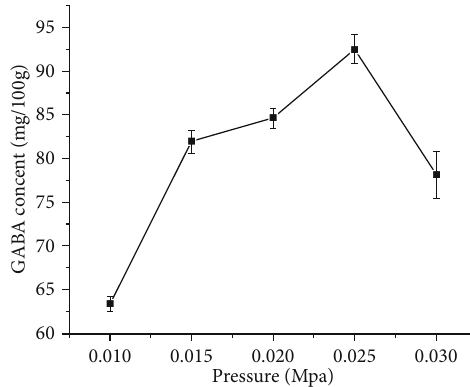
Figure 2: E ff ect of pressure on GABA